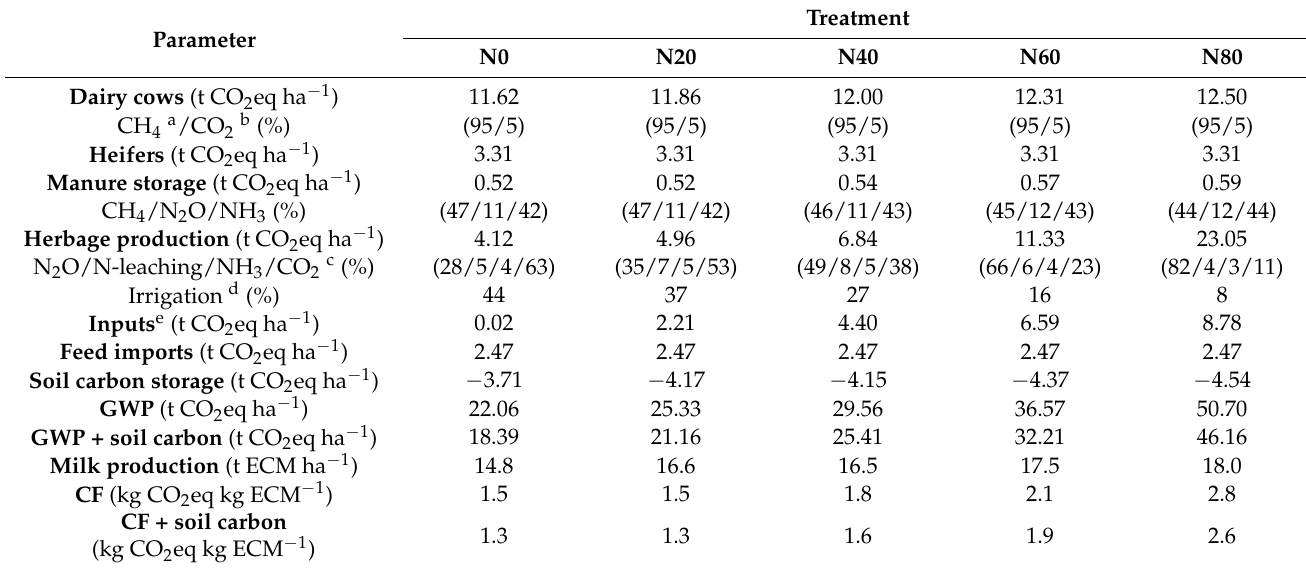
Table A1. Three-year average of the global warming potential (GWP) per hectare for the different nitrogen fertilization treatments and the CF expressed in kg CO 2 -equivalents (CO 2 eq) per